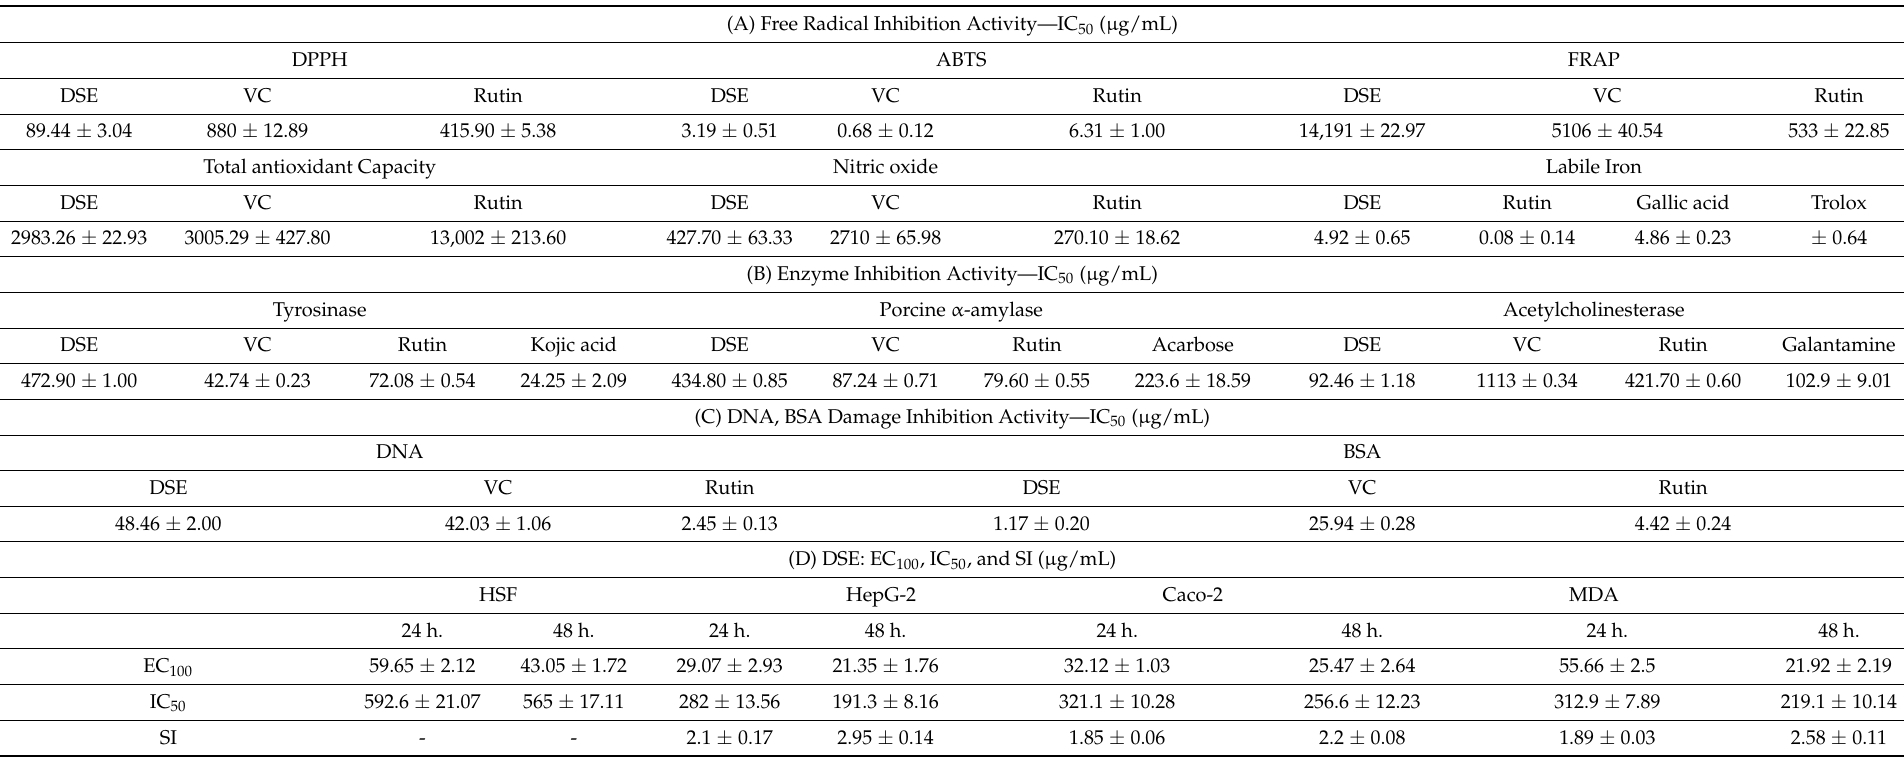
Table 1. Effects of DSE, vitamin C, and rutin on (A) Free radical inhibition activity, (B) Enzyme inhibition activity, (C) DNA, BSA damage inhibition activity, and (D) DSE: EC 100 , IC 50 , and SI against HSF, HepG-2, Caco-2, and MDA cell lines after treatment for 24 h and 48